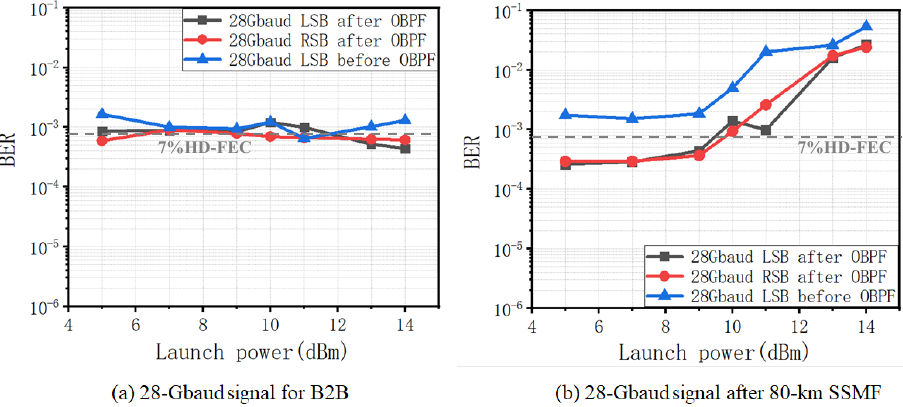
Figure 7. BER versus launch power. ( a ) 28 Gbaud for B2B; ( b ) after 80 km SSMF transmission.